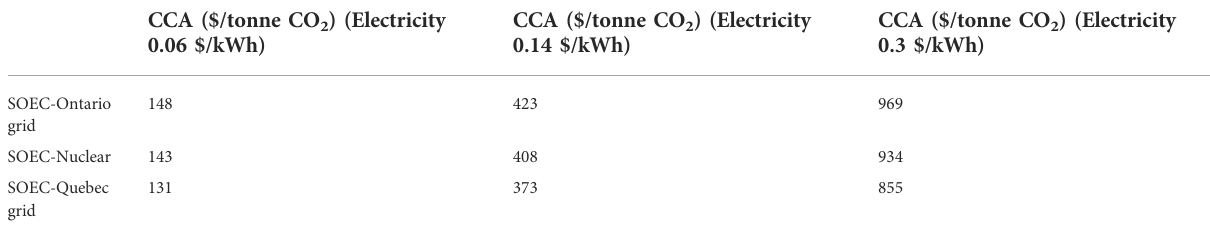
TABLE 2 CCA values for 5-year SOECs supplied with electricity from various power sources at 0.06, 0.14, and 0.3